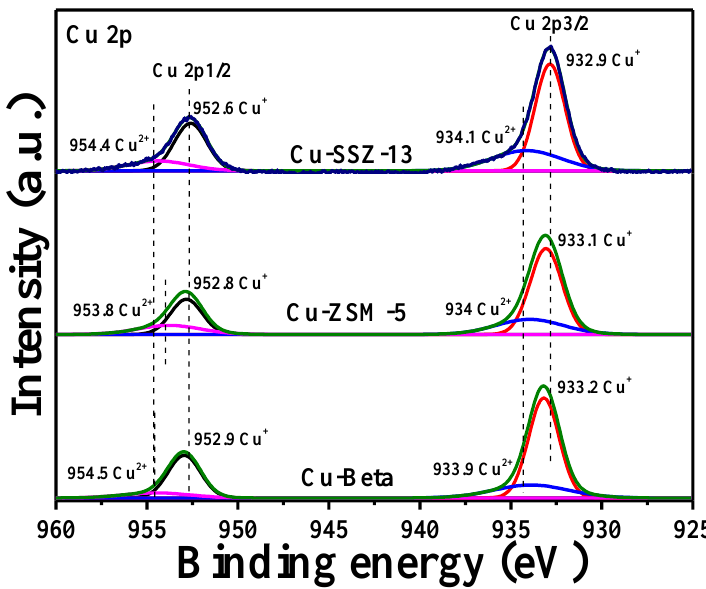
Figure 6. XPS spectra of Cu 2p for the copper-based zeolites.